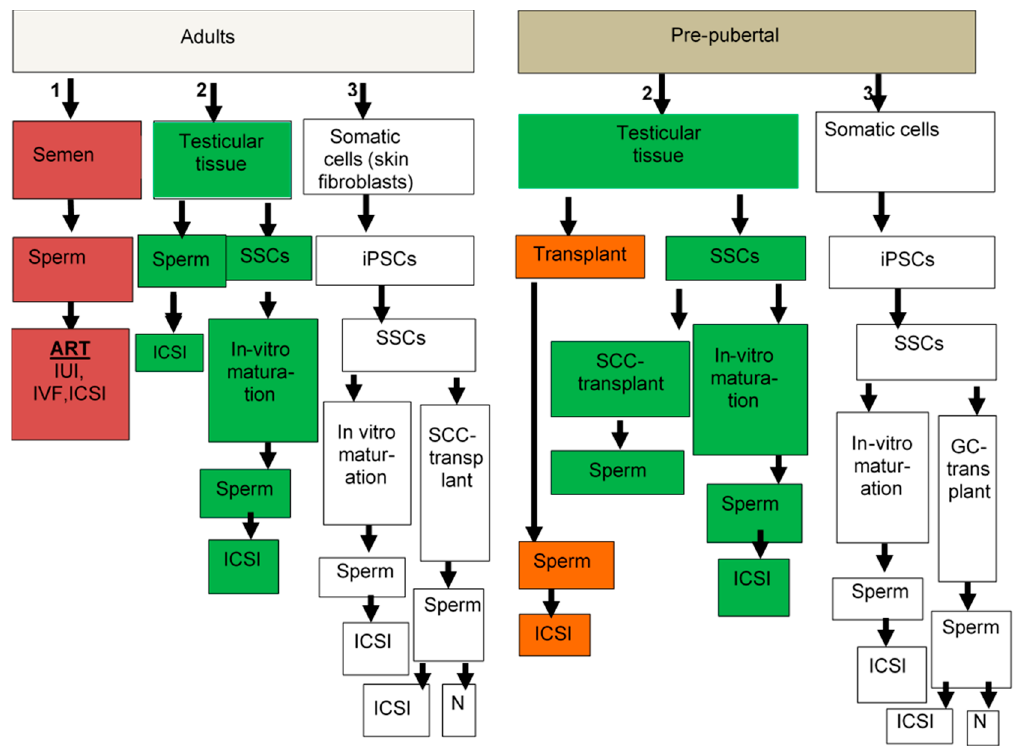
Figure 1. Suggested options for male fertility preservation. Adult patients, if they have sperm in the semen (option #1), can cryopreserve it for ART. If they do not have sperm in their semen, the second option is to use testicular tissue (option #2). If sperm is found in their testicular tissue, it can be used for ICSI. If no sperm is found, then isolated spermatogonia stem cells (SSCs) could be used for in-vitro maturation to generate sperm for use in ICSI. If this technology will not work, or SSCs are not found, then somatic cells could be used to generate iPSC (option #3) and to develop SSCs, which can be used for in-vitro maturation to generate sperm for ICSI or for germ cell transplantation, which leads to generation of sperm in the testes that can normally (N) fertilize oocytes and lead to pregnancy, or if very little sperm is generated, it can be used in ICSI. In pre-pubertal patients, only options #2 and #3 can be used; they do not generate sperm at this age and therefore option #1 is excluded. In pre-pubertal patients, only options #2 and #3 can be used. Testicular biopsies if they contain SSCs (option #2), can be used for transplantation to develop sperm for ICSI, or isolated SSCs can be used either to develop sperm in the testes by germ cell transplantation, or used for in-vitro maturation to develop sperm for ICSI. If testicular tissues do not contain SSCs, then somatic cells (option #3) can be used to generate iPSCs to develop SSCs and used as mentioned above for adult patients.